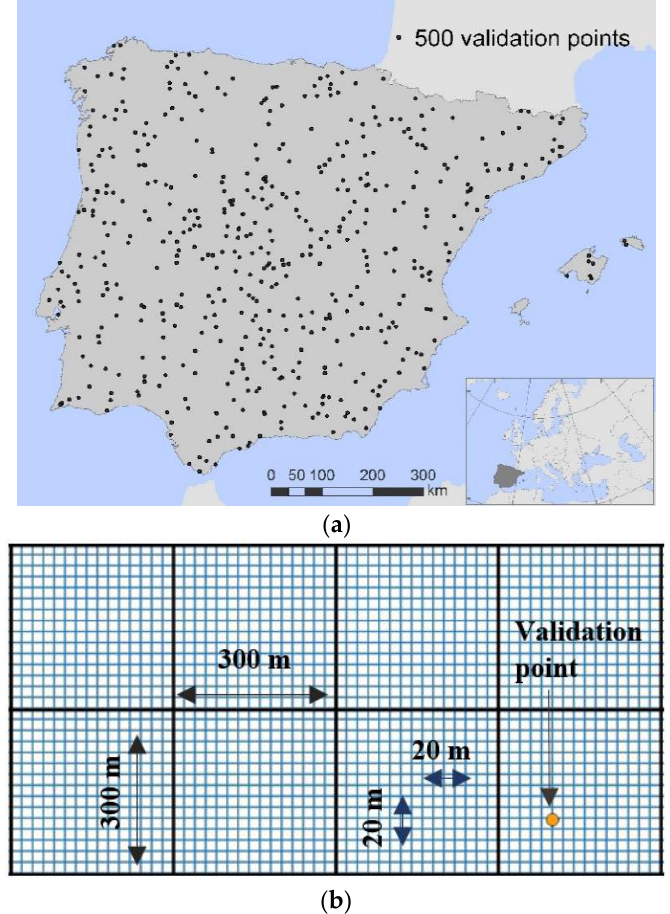
Figure 4. (a) Location of the validation points; (b) scheme of the vegetation map’s validation Figure 4. ( a ) Location of the validation points; ( b ) scheme of the vegetation map’s validation method.